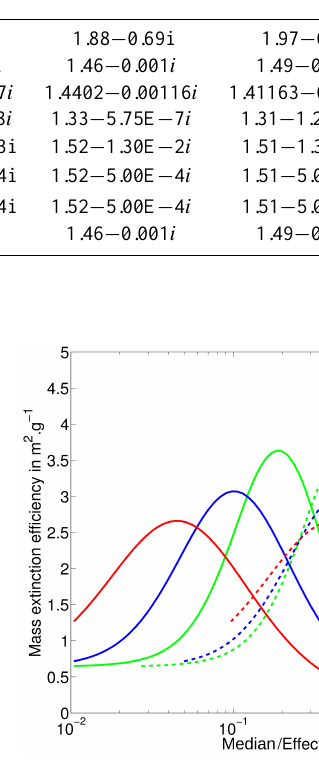
Fig. 1. Mass extinction efficiency as a function of the median radius in solid lines and in function of the effective radius in dashed lines for three geometric standard deviation at the wavelength of 550nm and a complex refractive index of